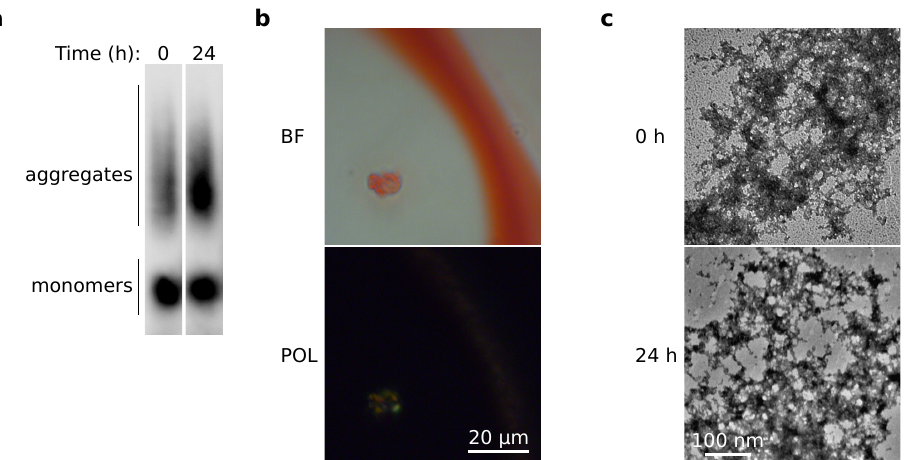
Figure 4. NOS1AP forms detergent resistant but non-amyloid aggregates in vitro. ( a ). Results of SDD-AGE for the NOS1AP samples. Anti-His antibodies were used for detection. ( b ). The microphotograph of the protein sample stained by Congo Red was obtained under transmitted (BF) and cross-polarized (POL) light. ( c ). TEM microphotographs of NOS1AP aggregates. a α Syn α Syn